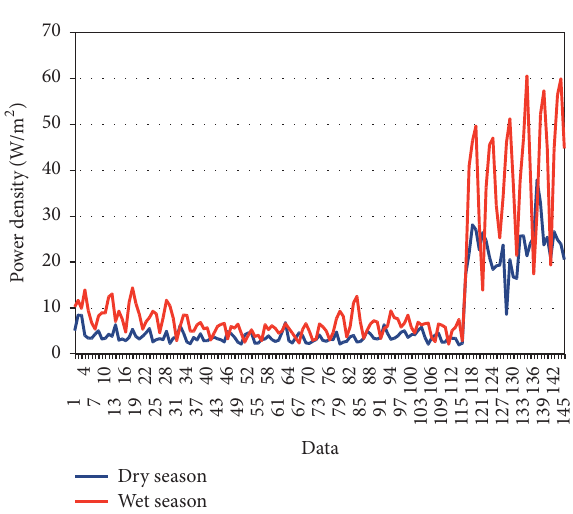
Figure 6: Mean wind power densities of both the dry and wet